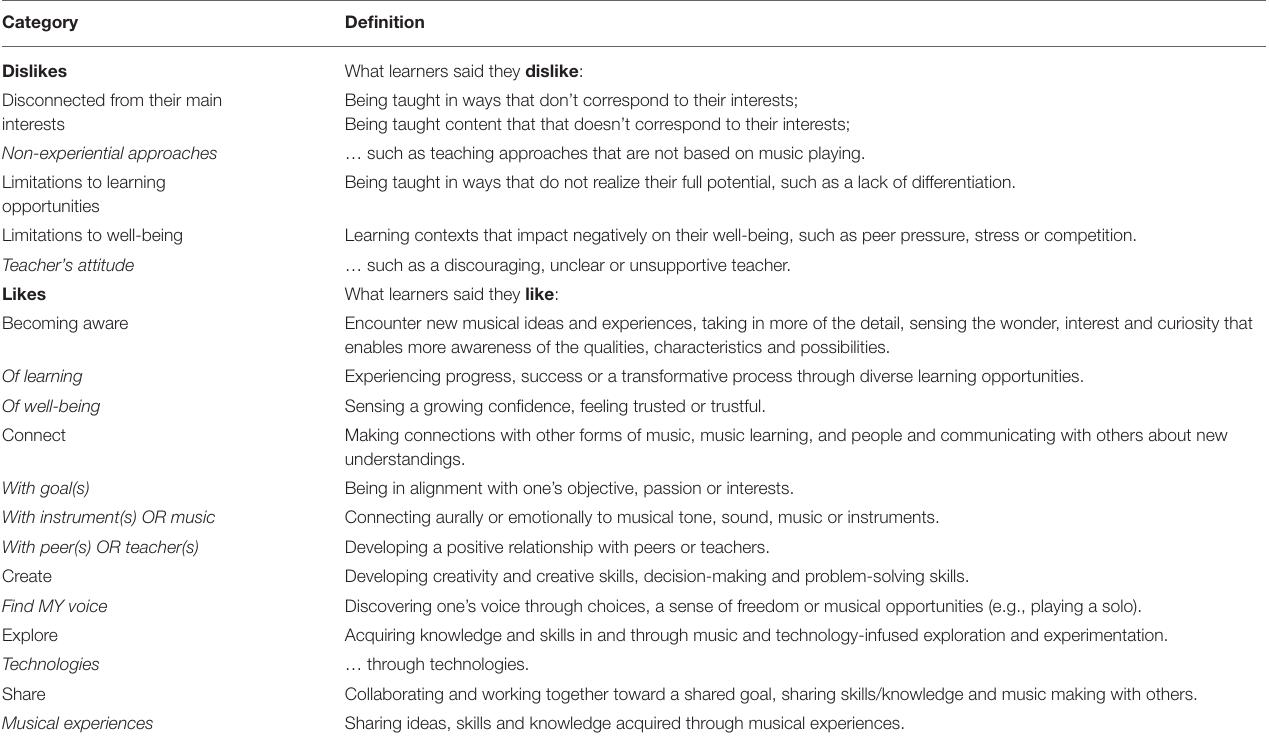
TABLE 6 | Final categorization based on O’Neill